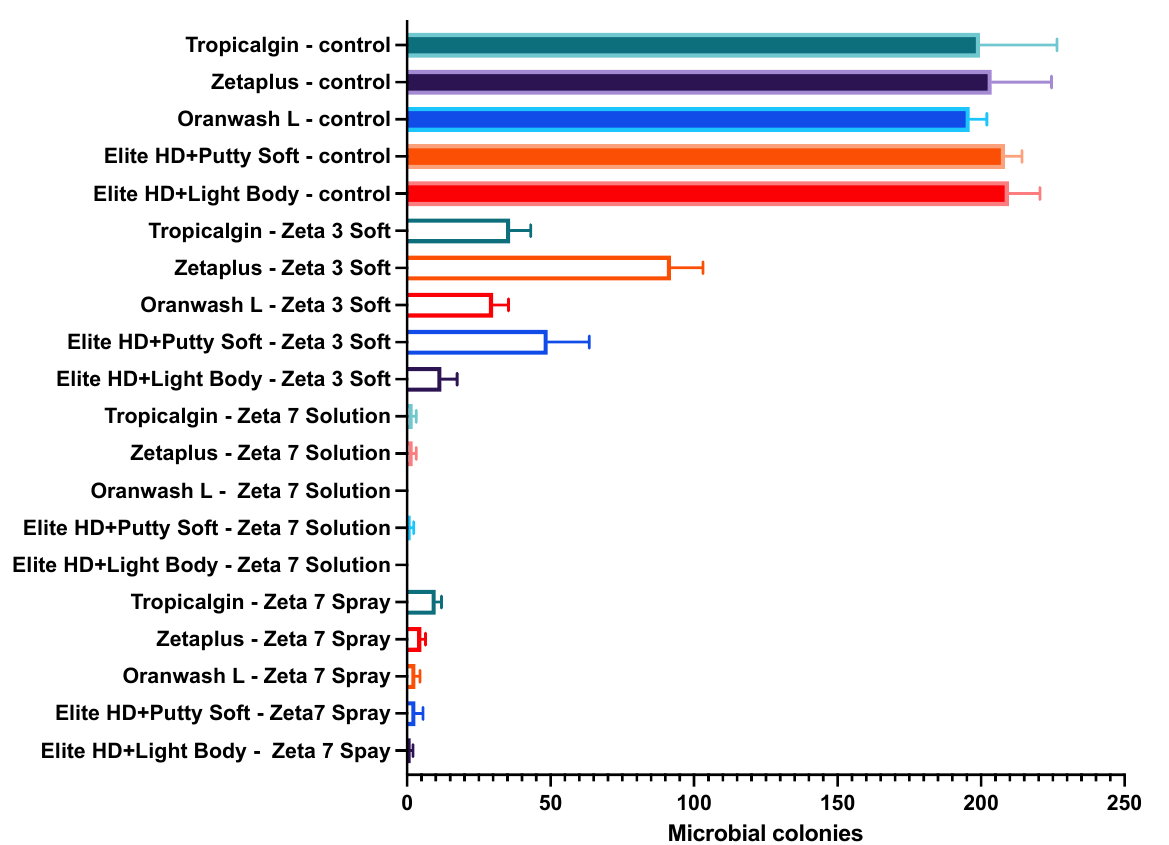
Table 6. The comparison of the results of the disinfection efficacy between the three used disinfect- ants.